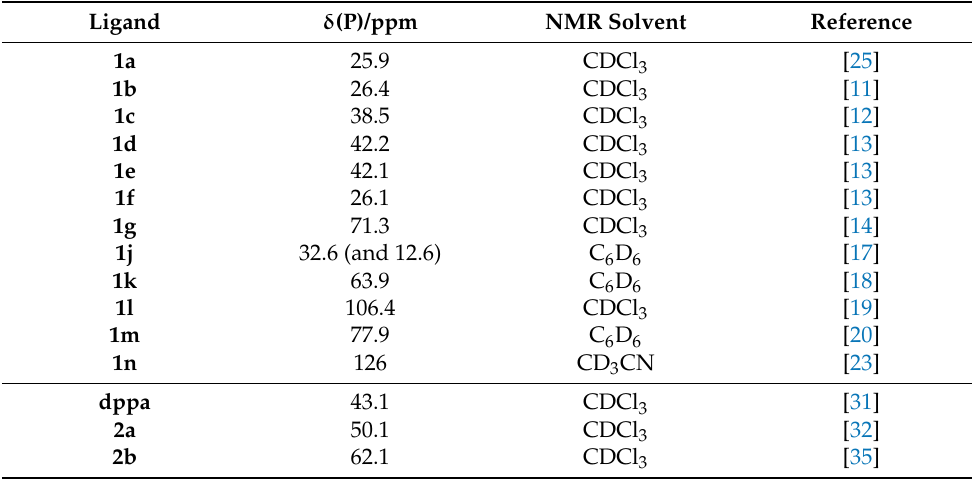
Figure 15. Selected proligands to anionic P–C 2 –N–C 2 –N–C 2 –P and P–C 2 –N–C 3 –N–C 2 –P ligands. Table 1. 31 P{ 1 H} NMR data for selected ligands discussed in this review.